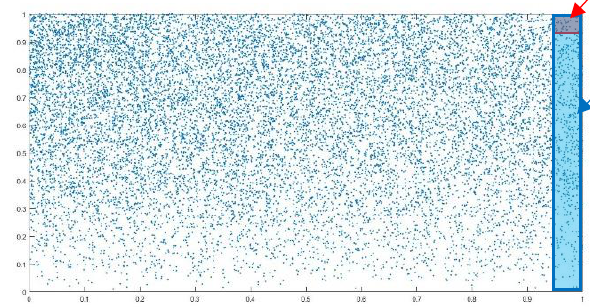
Figure 8 . Blue and red rectangles shows the points that are probably on the intersection of two and three planes, respectively. Blue rectangle in Fig. 8 shows the points that are probably on the intersection of two planes, because the distance between these points and their two closest planes, are nearly the same. Points surrounded with red rectangle in Fig. 8 are probably on the intersection of three planes, because their distance to their first nearest planes are close to each other.